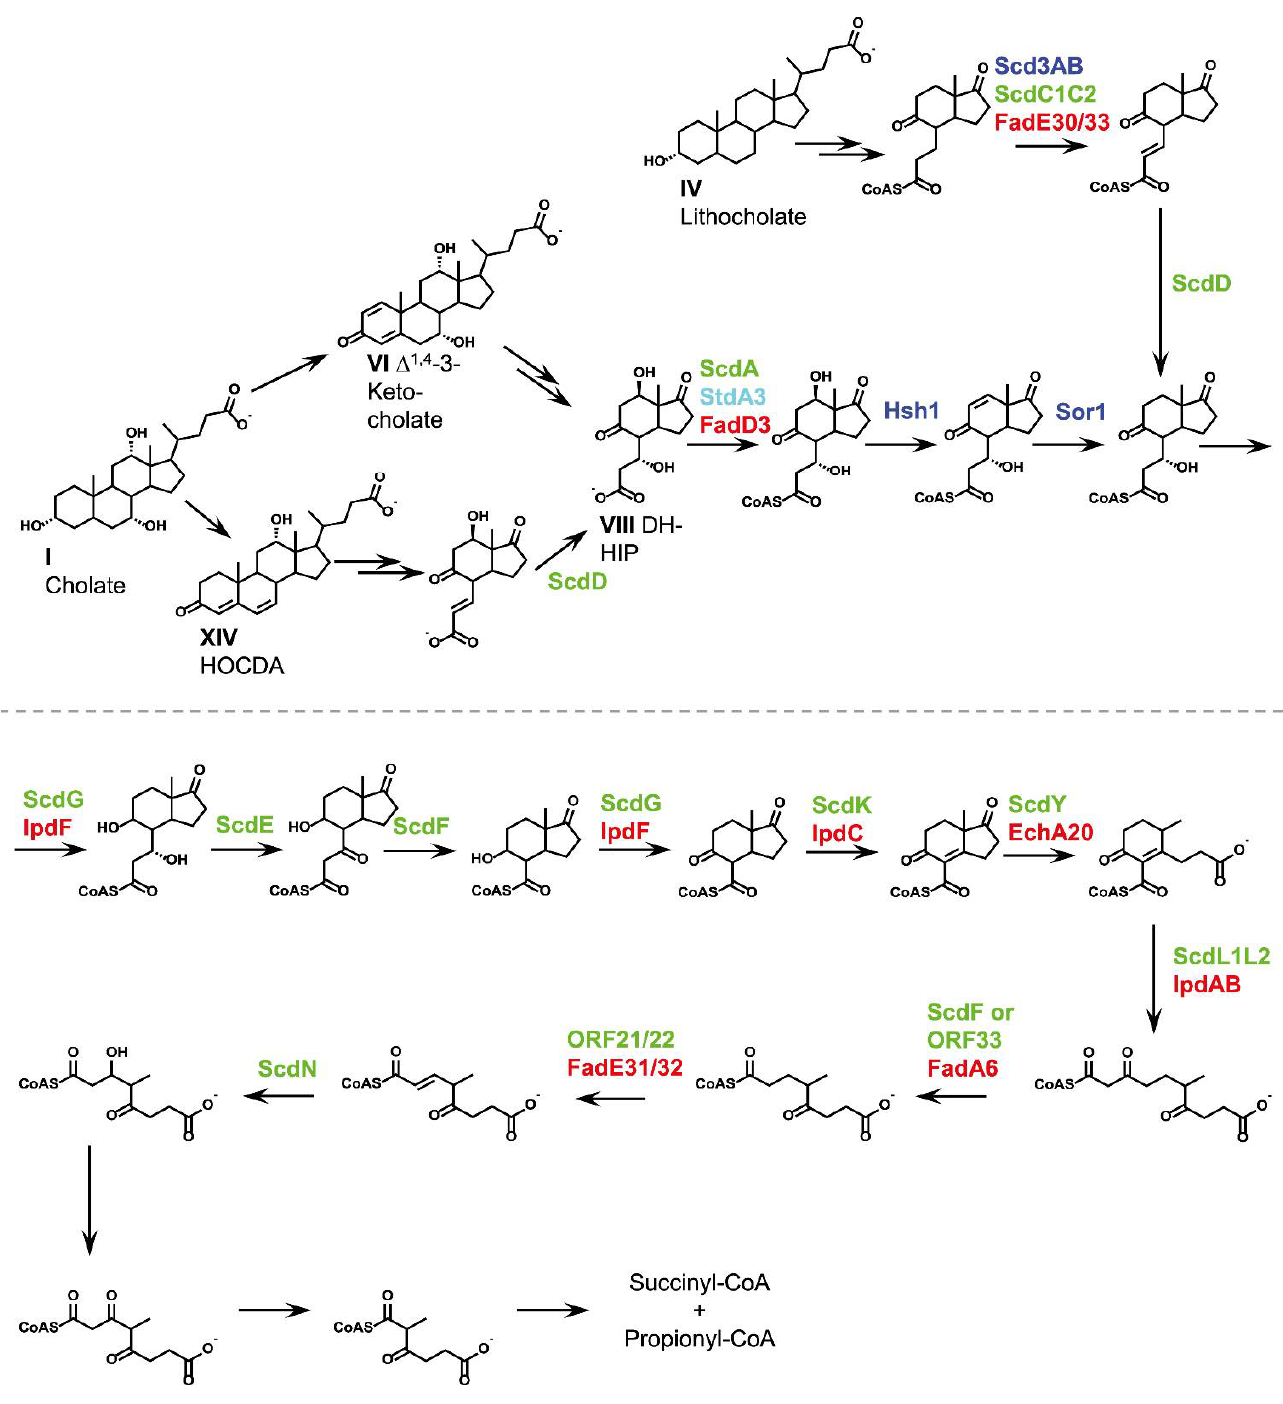
Figure 6. Degradation of H-methyl-hexahydro-indanone-propanoate (HIP) derivatives as phase 4 of bacterial bile acid degradation and channeling of differently hydroxylated bile acids into one common pathway via ∆ 1,4 -3-keto intermediates or ∆ 4,6 -intermediates. For bile acids, the respective deprotonated bile salts are depicted. Text colors indicate the organism, in which the respective enzyme has been identified: dark blue, P. stutzeri Chol1; light blue, P. putida DOC21; green, C. testosteroni TA441; red, R. jostii RHA1; magenta, Sphingobium sp. strain Chol11. HIP degradation is initiated by CoA-activation of the C 3 -side chain. In P. putida DOC21 [35], C. testosteroni TA441 [38] and R. jostii RHA1 [82], HIP CoA-ligases are encoded by the genes stdA3 , fadD3 , and scdA , respectively. After activation with CoA, the side chain is further degraded via a β -oxidation-like reaction sequence [39]. In bile acid degradation, this reaction sequence can depend on the organism and on the hydroxylation